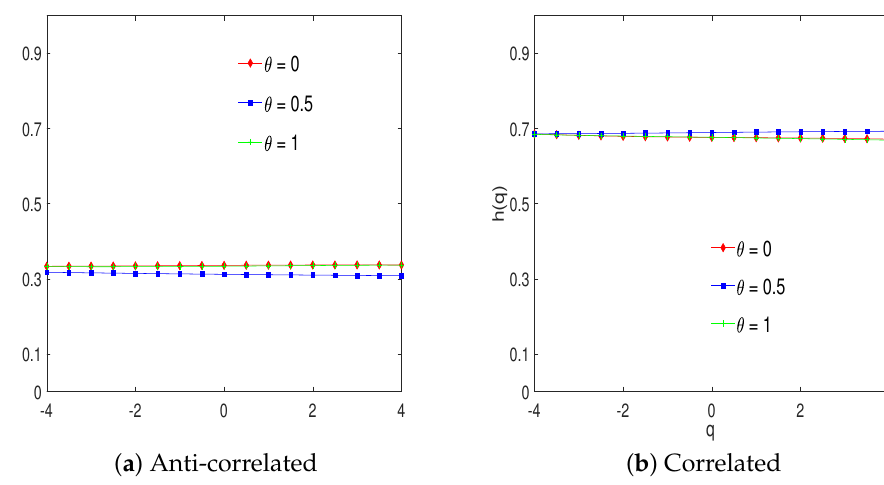
Figure 2. Independent monofractal series: the scaling